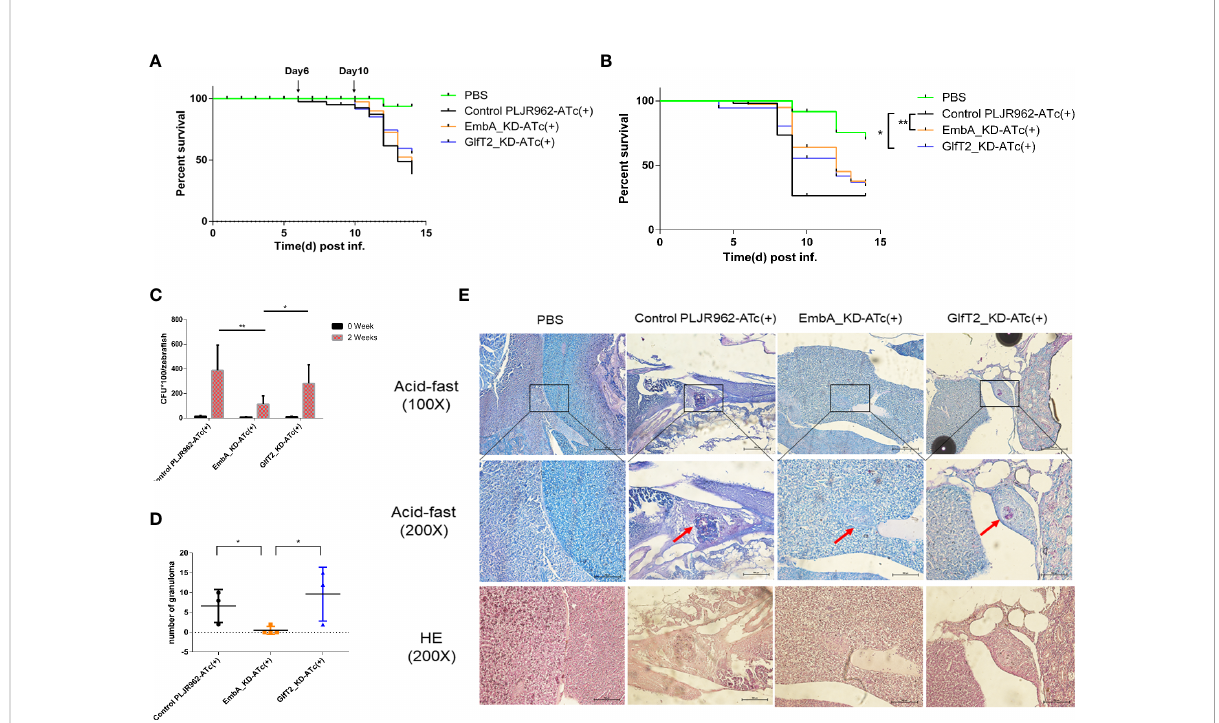
FIGURE 4 Zebra fi sh infection model with EmbA/GlfT2_KD strains. (A, B) Survival curves of larvae zebra fi sh infected by control PLJR962 strain and EmbA/ GlfT2_KD strains with initial colony forming unit (CFU) = 100 or 300, respectively ( n = 20 – 50). Log-rank tests are used to test the signi fi cance of the Kaplan – Meier survival curves: * P < 0.05, ** P < 0.01. (C, D) CFU counts and the granuloma numbers in adult zebra fi sh infected by control strain and EmbA/GlfT2 knock-down strains, respectively, at 2 weeks post-injection. Data were plotted as mean ± SD. Two-way analysis of variance tests were used for all signi fi cance analysis: * P < 0.05 and ** P < 0.01. (E) Acid-fast staining and hematoxylin and eosin (H&E) staining of zebra fi sh sections. Acid-fast staining was observed with an optical microscope at ×100 and ×200, and the visual fi eld of H&E stain was the corresponding area of acid-fast staining at ×200 magni fi cation. The red arrow points to the granuloma, and the purplish red color in the center of acid-fast granuloma represents the